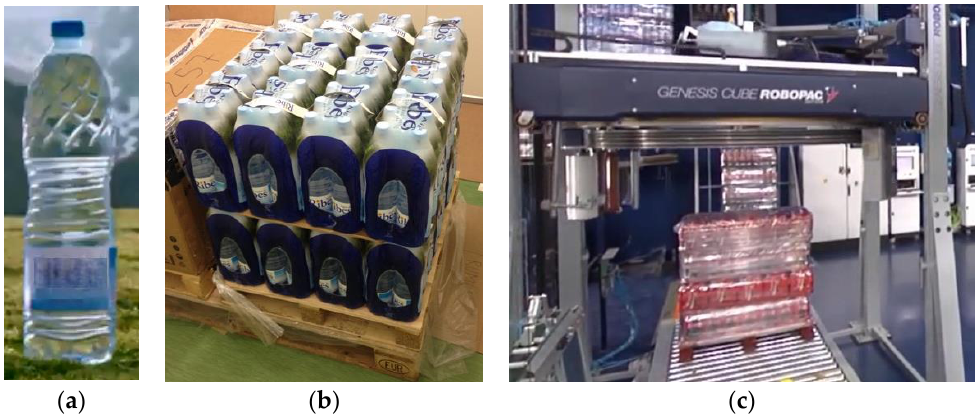
Figure 1. A multilevel system: ( a ) a single bottle; ( b ) bottles grouped in bundles; ( c ) pallet and palletizing plant.